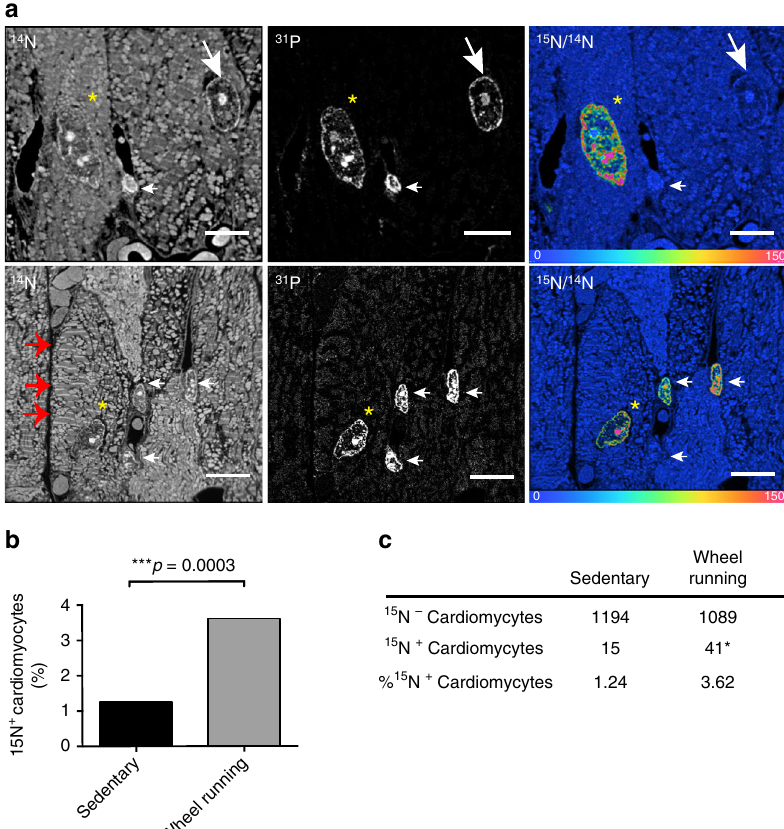
Fig. 1 Cardiomyocyte cell cycle activity is increased in the exercised heart 15 N-thymidine was administered continuously for 8 weeks to young adult mice (2 months old) undergoing voluntary wheel running vs. sedentary activity. a Mass 14 N image (top left, bottom left) shows histological details such as sarcomeres (large red arrows), mass 31 P image (center, top and bottom) shows nucleus and chromatin condensation, while the hue-saturation-intensity image (mosaic, top, and bottom right) demonstrates nuclear 15 N labeling of a cardiomyocyte (yellow asterisk), non-labeled cardiomyocytes (large white arrows) can also be found in that section, as well as, two labeled non-cardiomyocytes (bottom right, small white arrows) and one non-labeled non-cardiomyocyte (top right, small white arrow). The scale ranges from blue, where the ratio is equivalent to natural ratio (0.37%, expressed as 0% above natural ratio (enrichment over natural ratio)), to red, where the ratio is 150% above natural ratio. 15 N-thymidine has labeled the nucleus while the cytoplasm is at the natural abundance level. Scale bar = 10 μ m. b Comparison of the percentage of 15 N-labeled cardiomyocyte nuclei in exercised to sedentary young adult hearts. Exercise increases cardiomyocyte cell cycle activity (sedentary:exercise = 1.24:3.62%; >1000 cardiomyocytes from four mice per group were counted, *** p = 0.0003, Fisher ’ s exact test). c Contingency table showing the absolute numbers and percentage calculations of 15 N-positive and 15 N-negative